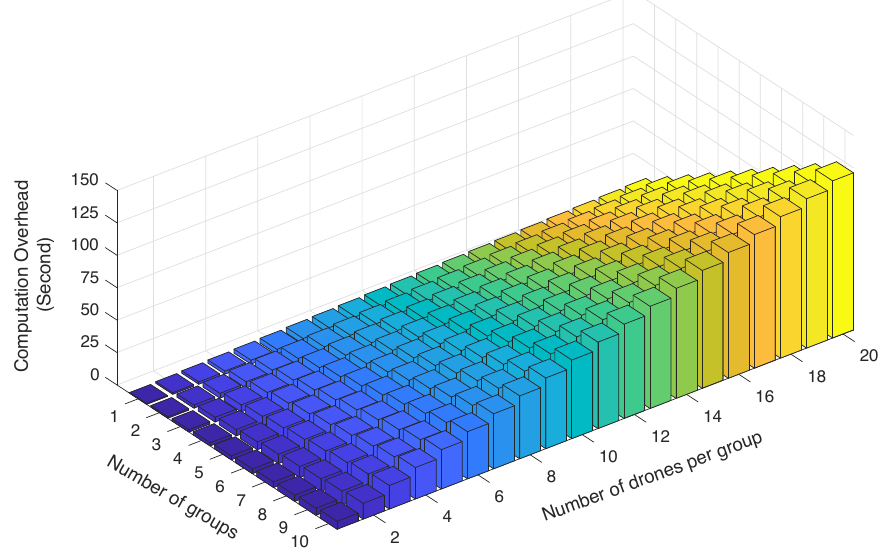
Figure 9. Computation overhead for monitoring